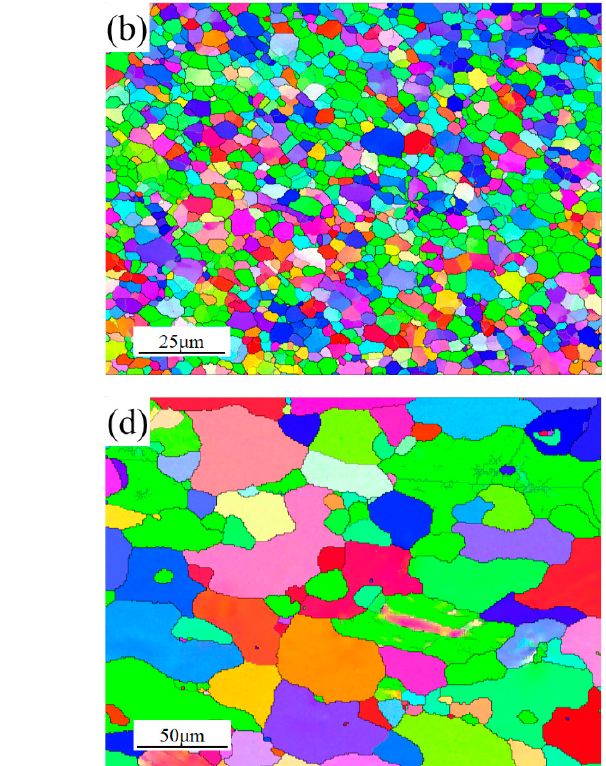
Figure 5. ( a – c ) Average grain size and ( d ) misorientation angle distributions of SZ-(1–3). 3.3.2. Qualitative and Quantitative Statistics of Texture The pole figure (PF) maps in Figure 6 show that the sharper texture of SZ-1, SZ-2 and SZ-3 appear on the different crystal planes. It has the strongest texture in SZ-1 region (MAX = 10.06), while the texture density in SZ-2 region is the weakest (MAX = 3.07). The inverse pole figure (IPF) maps show the same change law as the PF. Figure 7a–c shows the distribution of main textures of SZ-1, SZ-2 and SZ-3. The texture content of the three positions is quite different. Meanwhile, SZ-1 and SZ-3 had the strongest texture density in <001>//PD, while SZ-2 had the strongest texture density in <110>//PD. In addition, Cube texture appears in SZ, which was generally considered the recrystallization texture of high stacking fault energy (SFE) metals (such as aluminum) [7]. In order to identify the texture of each grain, the main texture components were studied, and the criterion of error was set as 10°. Red, green, blue and yellow were used to represent <111>//PD, <110>//PD, <001>//PD and Cube texture, respectively. The results are shown in Figure 7d.